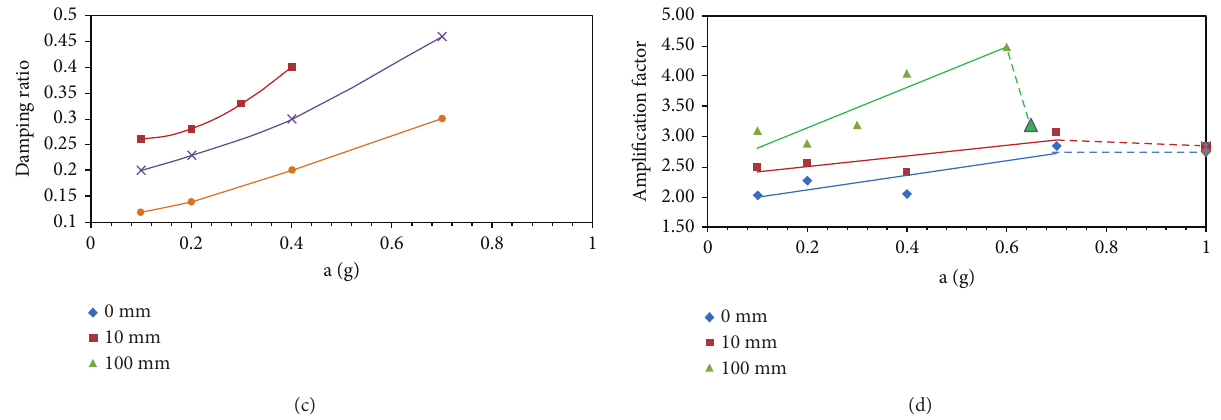
Figure 8: Variation of several parameters at A5 with dynamic loading intensity. (a) Peak value of transfer function spectrum. (b) Natural frequency. (c) Damping ratio. (d) Amplification